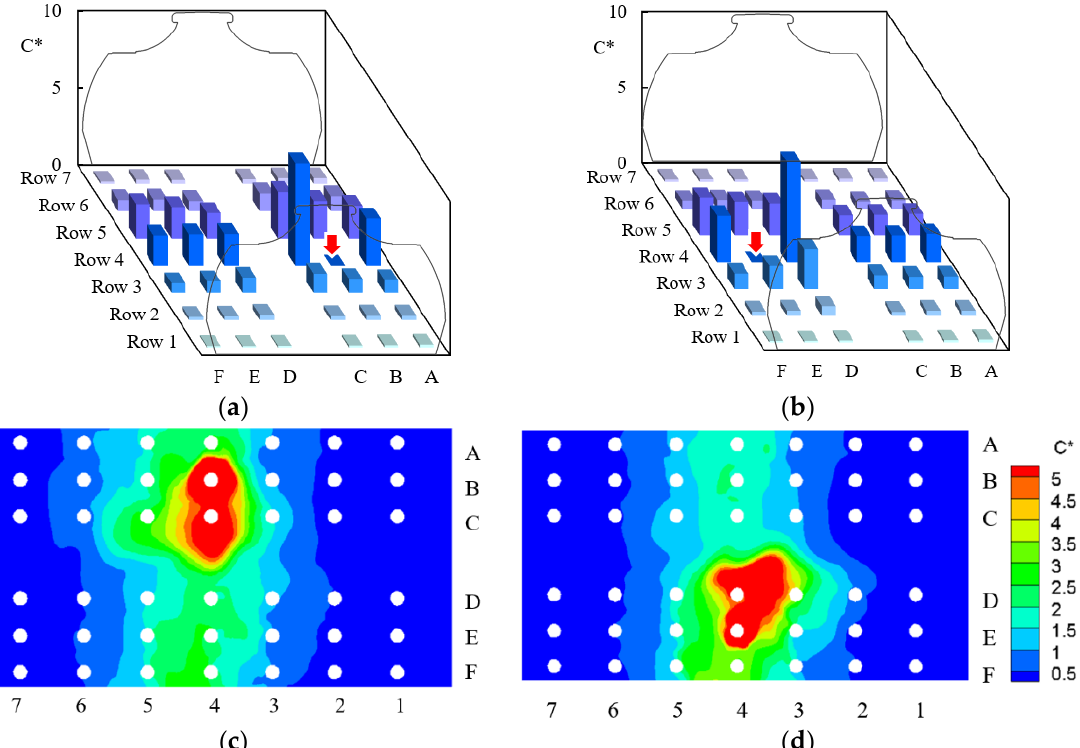
Figure 7. Normalized pollutant concentrations: ( a ) in respiratory zones of passengers in different seats for pollutant source at seat 4B, ( b ) in respiratory zones of passengers in different seats for pollutant source at seat 4E, ( c ) concentration distribution on a horizontal plane of the passenger’s nostril height for pollutant source at seat 4B, ( d ) concentration distribution on a horizontal plane of the passenger’s nostril height for pollutant source at seat 4E.